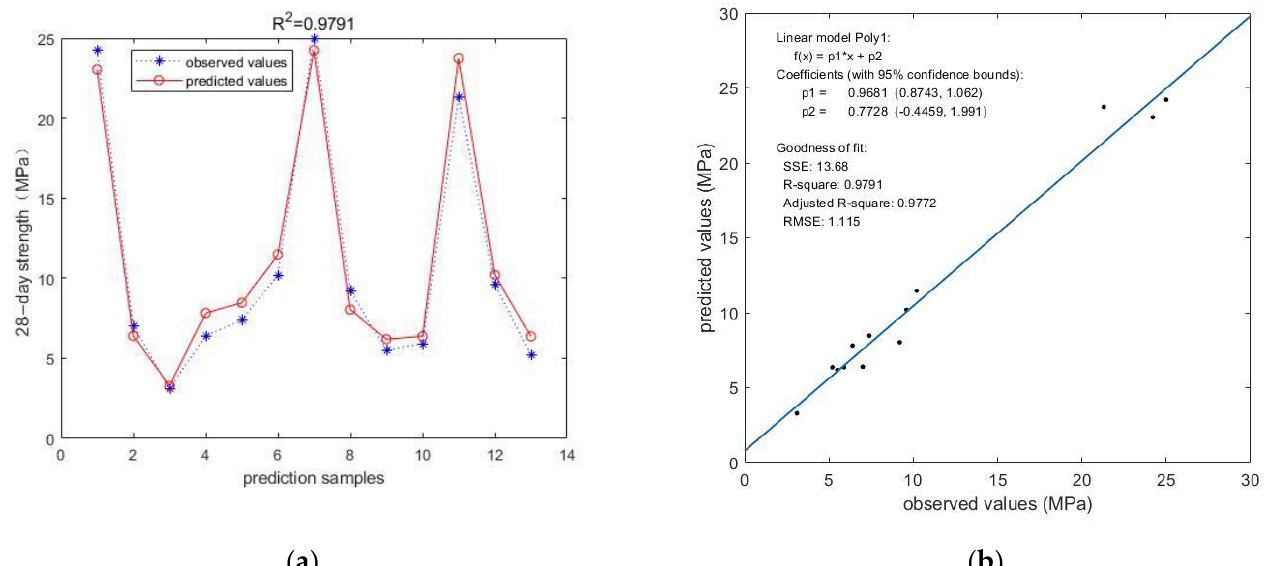
Figure 12. BP neural network for compressive strength prediction of cemented material dam: ( a ) prediction results of compressive strength and ( b ) linear regression equation.